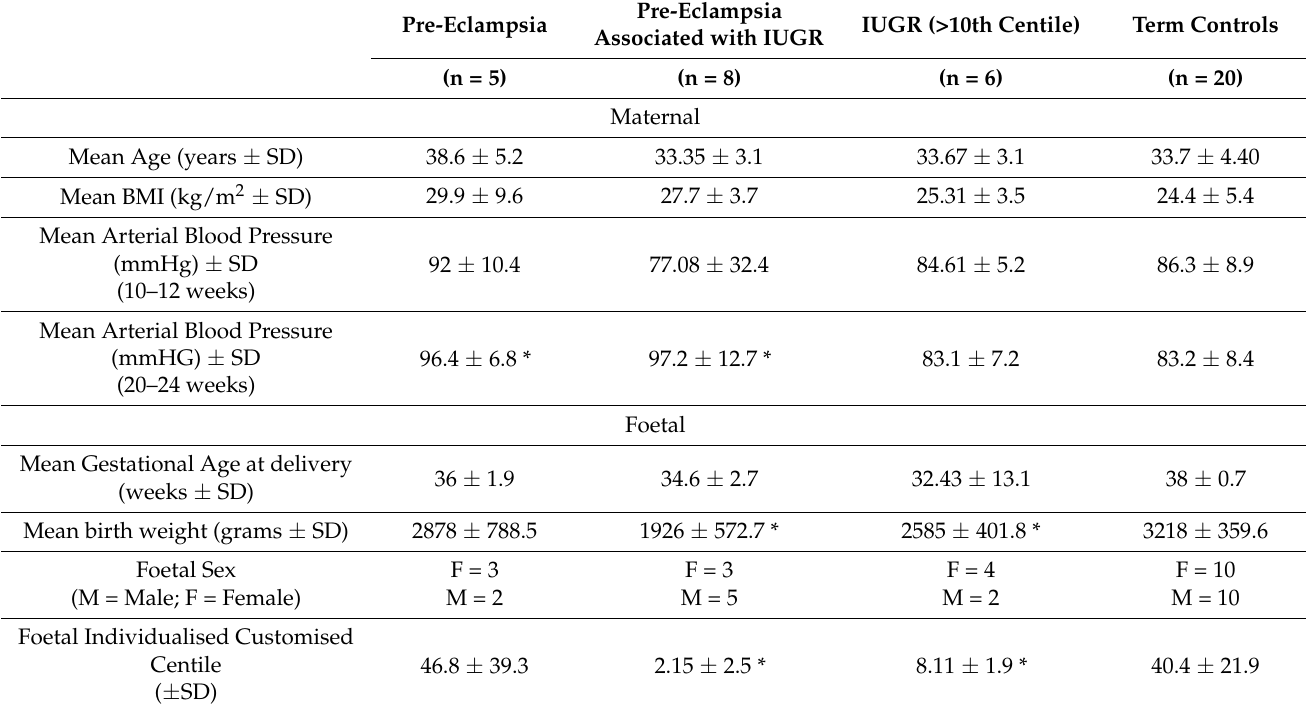
Table 1. Patient characteristics in study cohort. Data are represented as mean ± SD. Mean arterial pressure has been calculated as MAP = [Systolic BP + (2 × Diastolic BP)]/3. Pre-Eclampsia Pre-Eclampsia IUGR (>10th Associated with IUGR